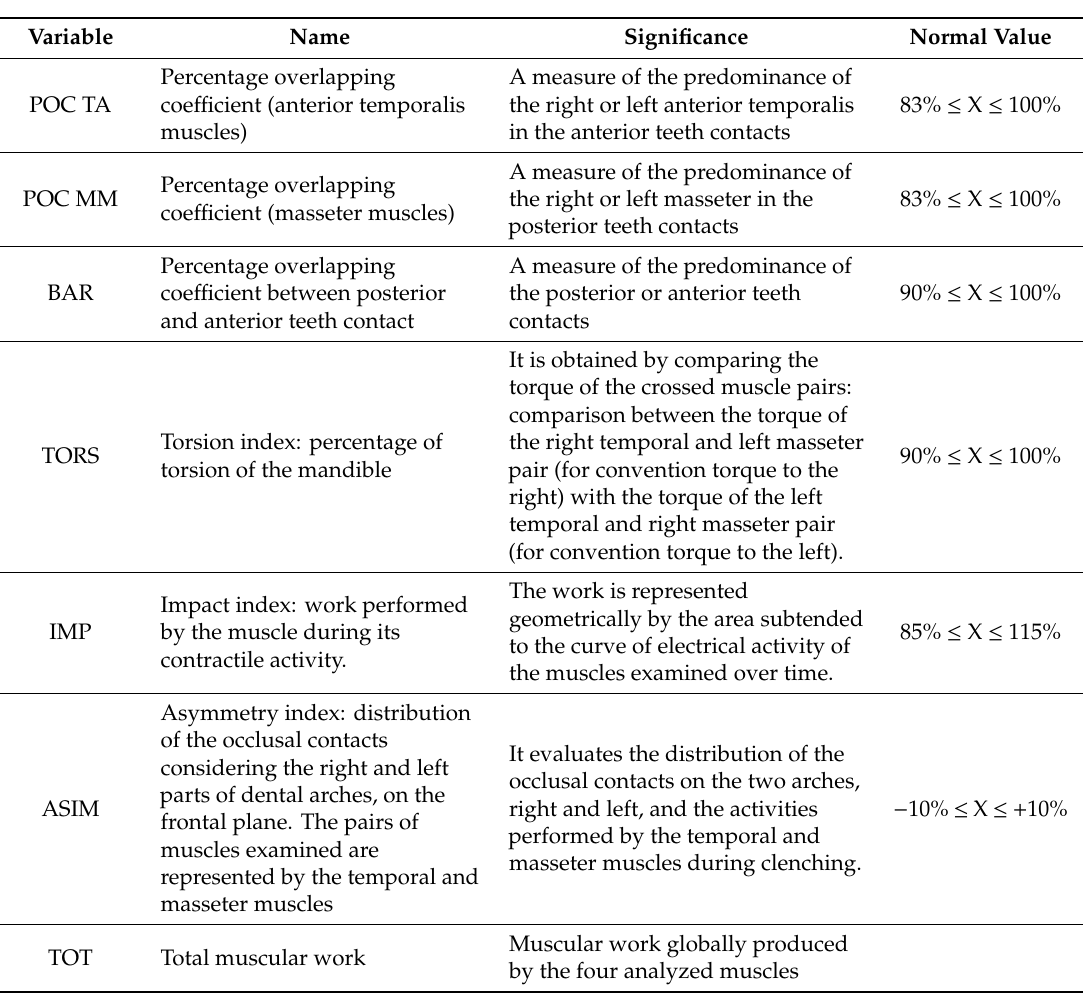
Table 1. Variables